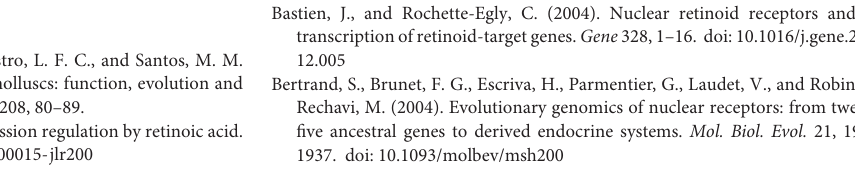
Supplementary Table 1 | Primers used for RT-qPCR analysis and fusion vectors